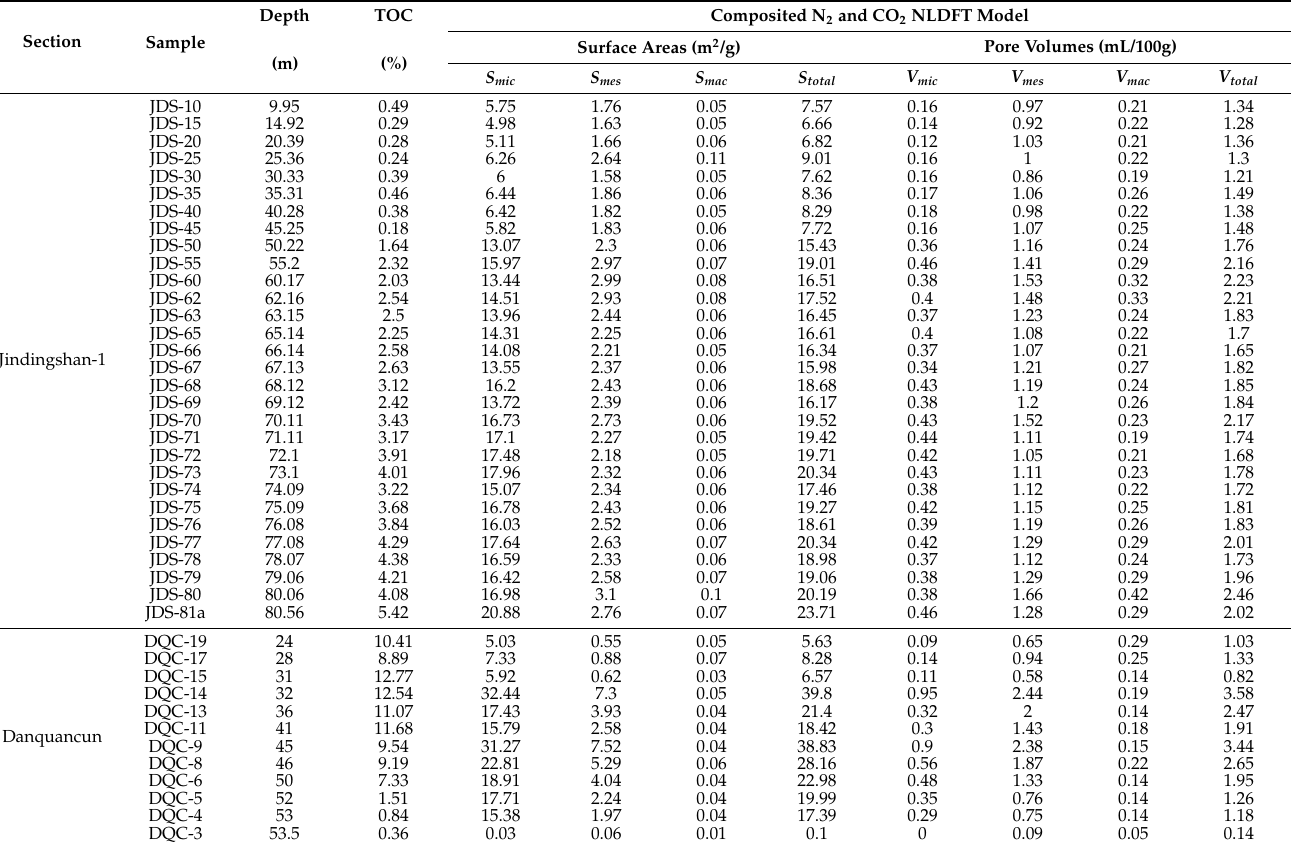
Table 4. Pore structure parameters were obtained by the Nonlocal Density Functional Theory (NLDFT)